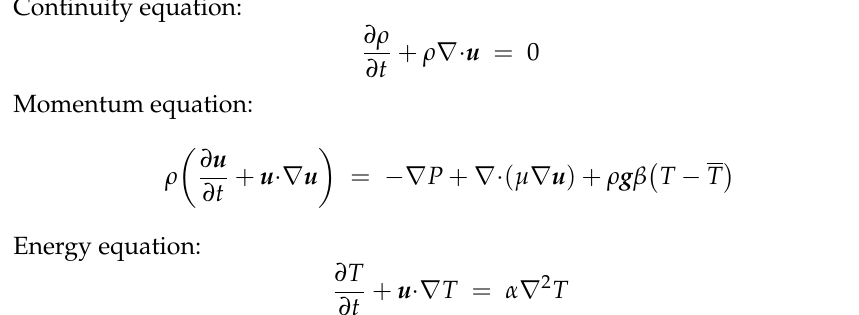
Figure 1. Boundary conditions for natural convection in a side-heated square cavity.